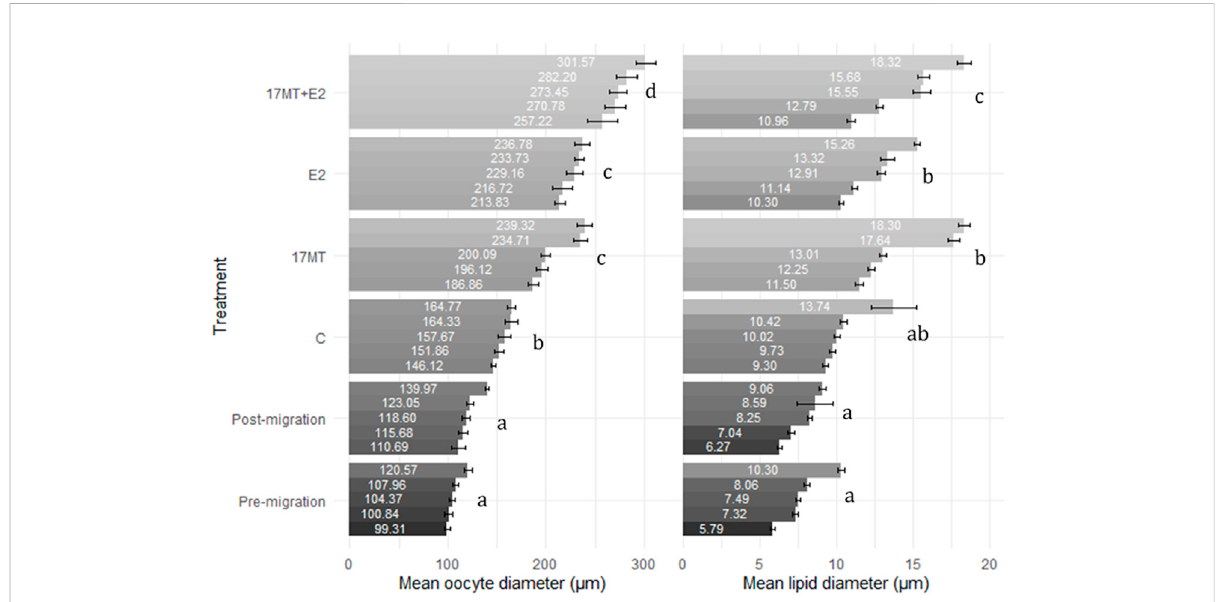
FIGURE 6 Oocyte ( N = 10 oocytes per eel) and lipid droplet diameter ( N = 10 lipid droplets per oocyte) for ovarian tissue obtained by analyzing the histological images. Mean diameter is presented for each eel with standard error bar. Six treatment groups are presented: pre-( N = 5 eels) and post- simulatedmigration( N =5eels);control(Cgroup; N =5eels);17 α -methyltestosterone(17 MTgroup; N =5eels);17 β -estradiol(E2group;N=5eels), and co-implanted 17 MT and E2 (17 MT + E2 group; N = 5 eels). Observations are sorted from lowest to highest observation for each group within each